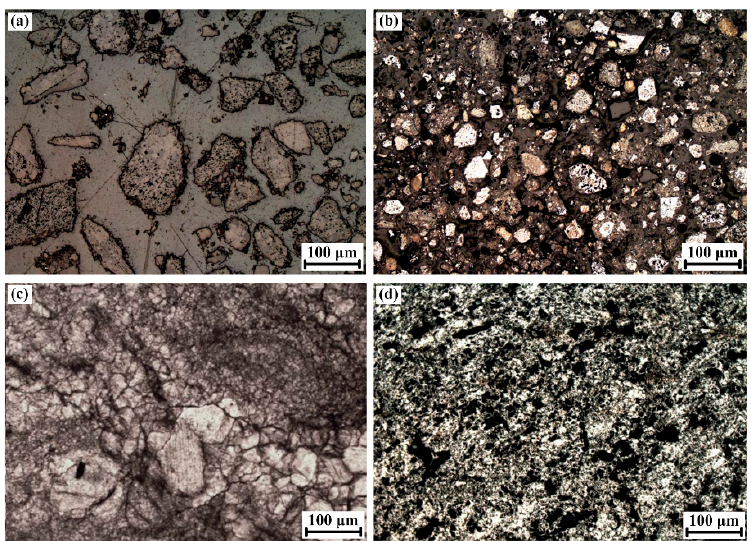
Figure 1. Optical microstructure of the four materials used in the tests: ( a ) MLG-S; ( b ) ONM-N-F; ( c ) MLC-N; ( d ) ONM-N.